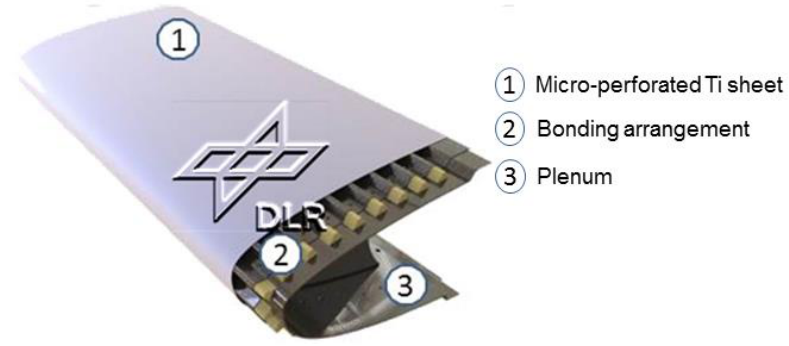
Figure 2. Example of an HLFC leading edge suction panel .